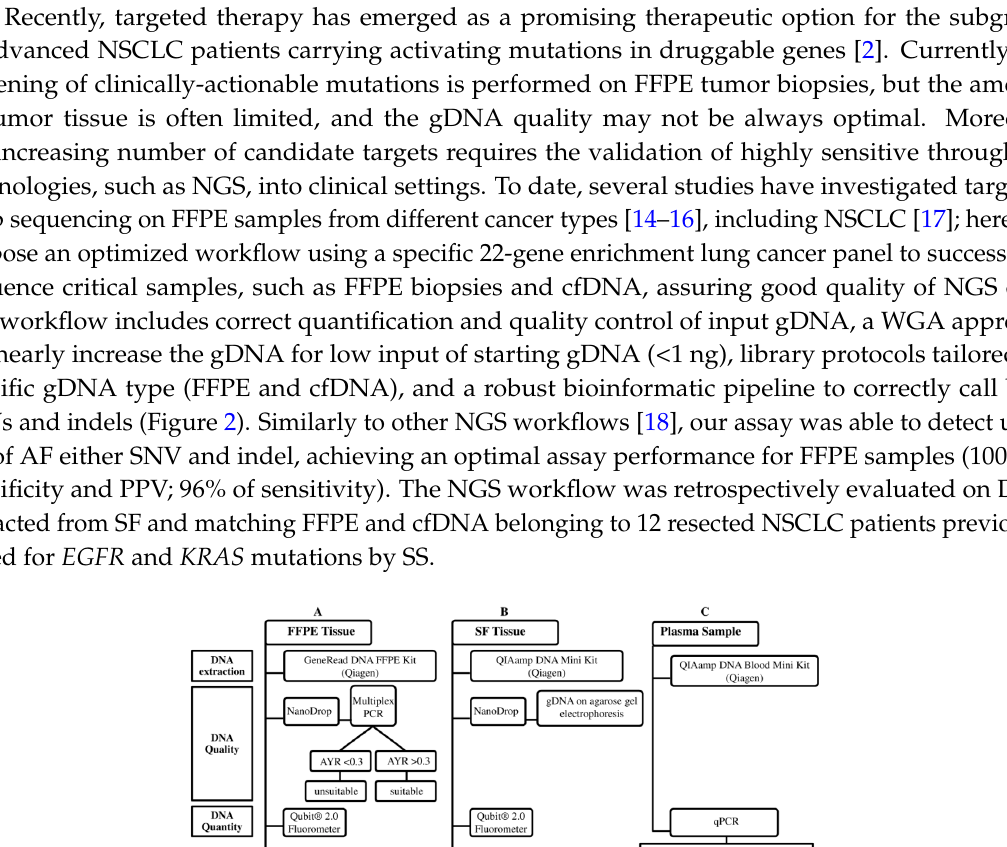
for the multiplex PCR DNA quality control ( A ) and WGA technique ( C